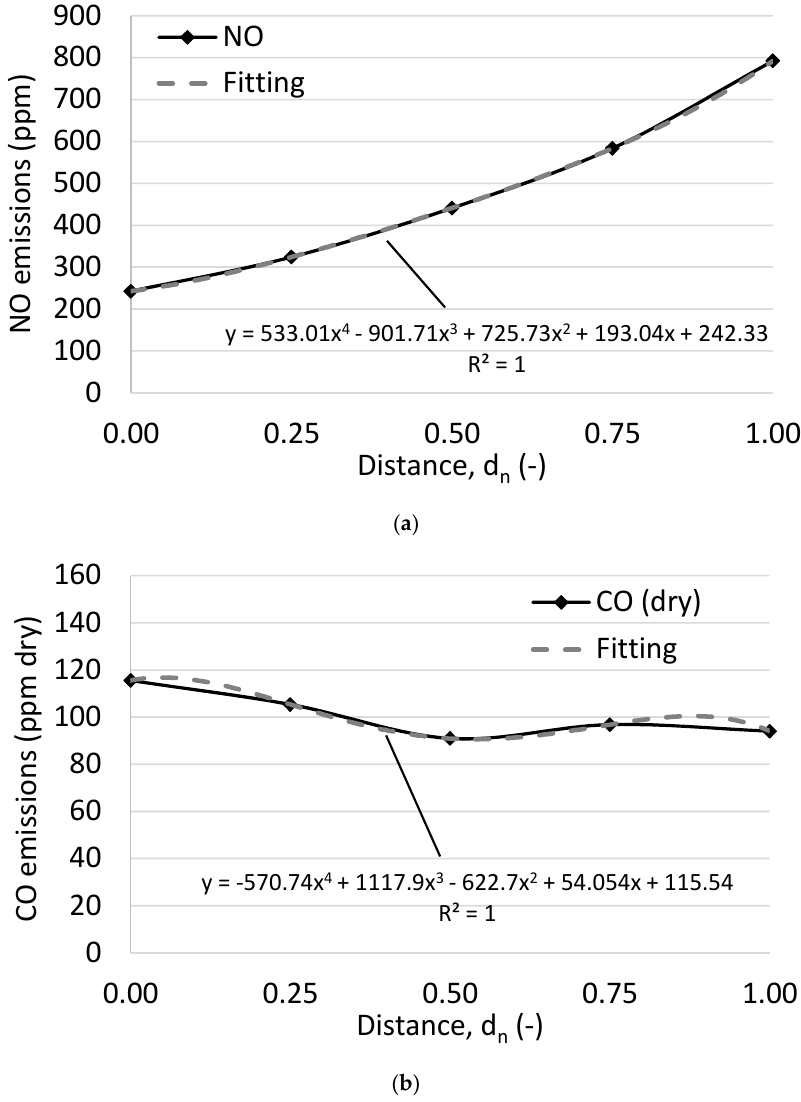
Figure 3. ( a ) NO, and ( b ) CO (dry) emissions for the five representative cycles with a different d n value. Their fitted correlations are also shown, together with the R 2 .